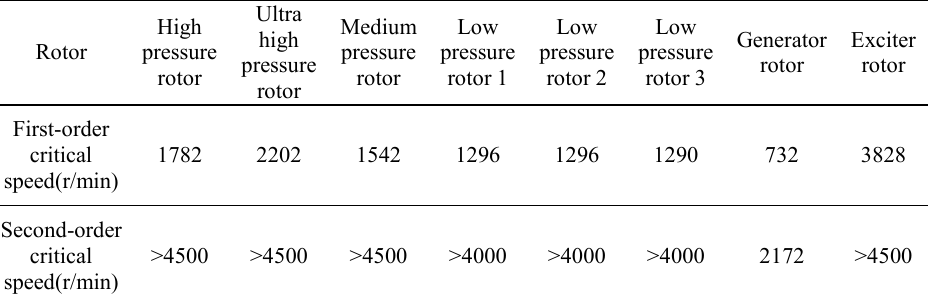
Table 1. The critical speed calculation table of the six-cylinder six-exhaust rotor.